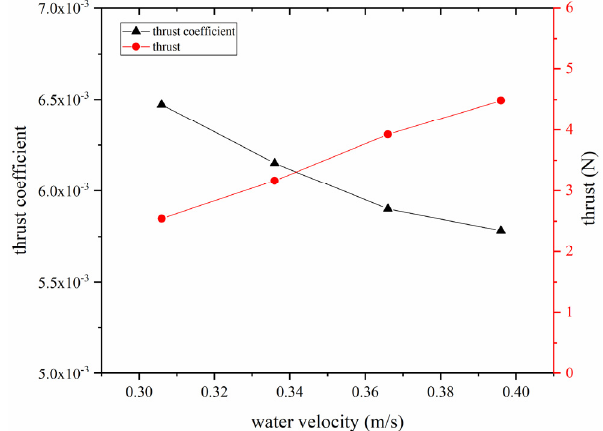
Figure 16. The thrust and thrust coefficient with 𝑣 .